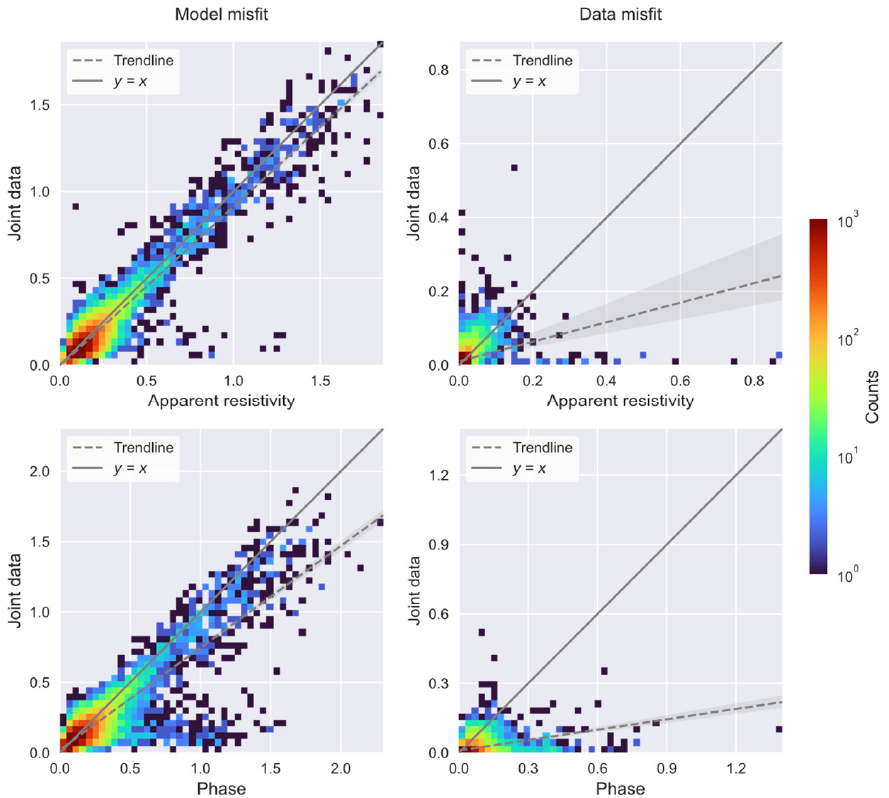
Figure 11. The model and data misfit scatter density plots between the apparent resistivity, phase and joint data for the test set. The left and right columns are the comparison results of model misfit and data misfit separately. The top row places the comparison results between the apparent resistivity and joint data. The bottom row shows the comparison results between the phase and joint data. Table 5. Mean model and data misfits of the test set for the apparent resistivity, phase and joint data.